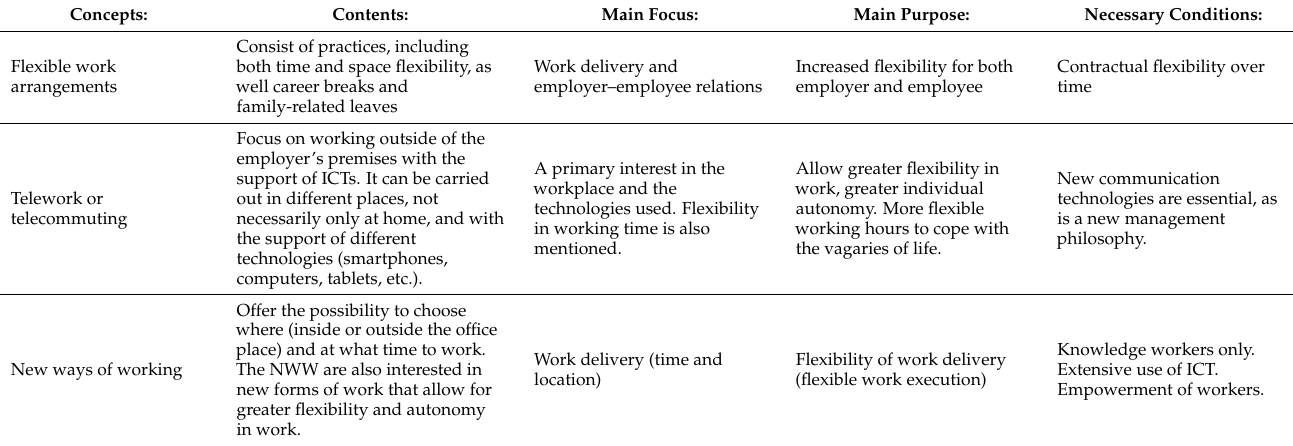
Table 2. Comparison of various concepts: flexible work arrangements, telework or telecommuting, and